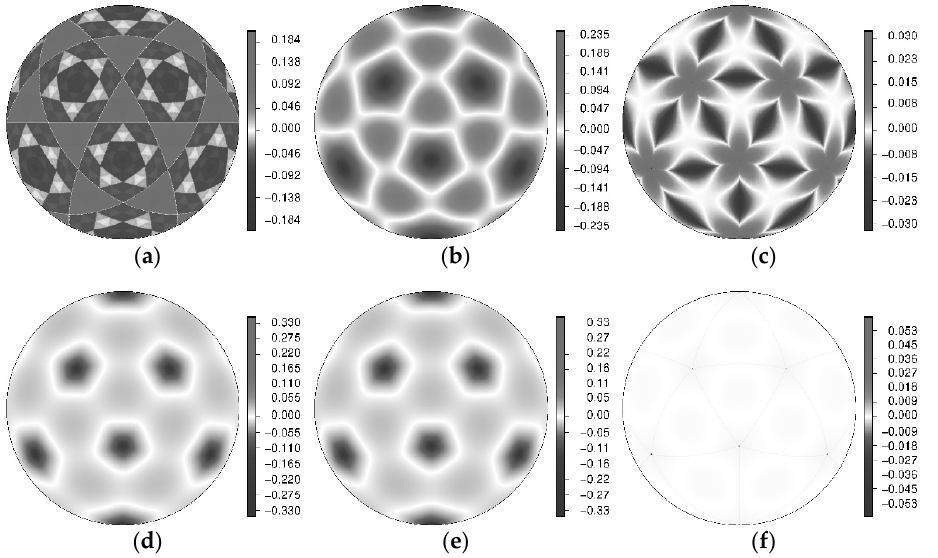
Figure 8. Spherical distributions of D area of different grids at level 9. ( a ) NOPT grid. ( b ) SPRG grid. ( c ) HR grid. ( d ) SCVT grid. ( e ) XU grid. ( f ) OURS grid.